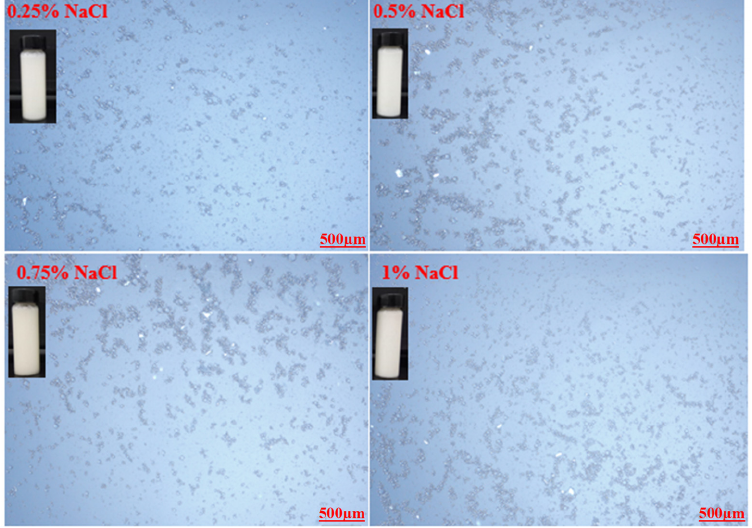
Figure 6. Optical microscopy images of 1%-CT/1%-AG emulsion at various NaCl concentrations.